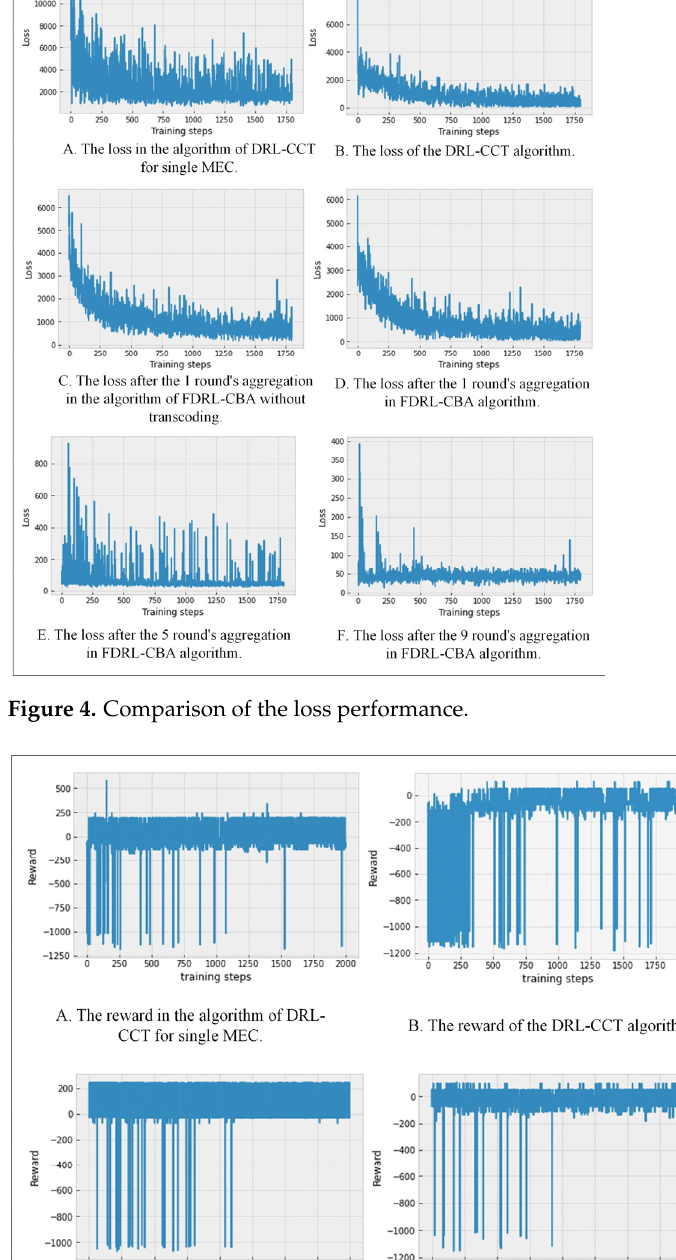
Figure 5. Comparison of the reward performance.